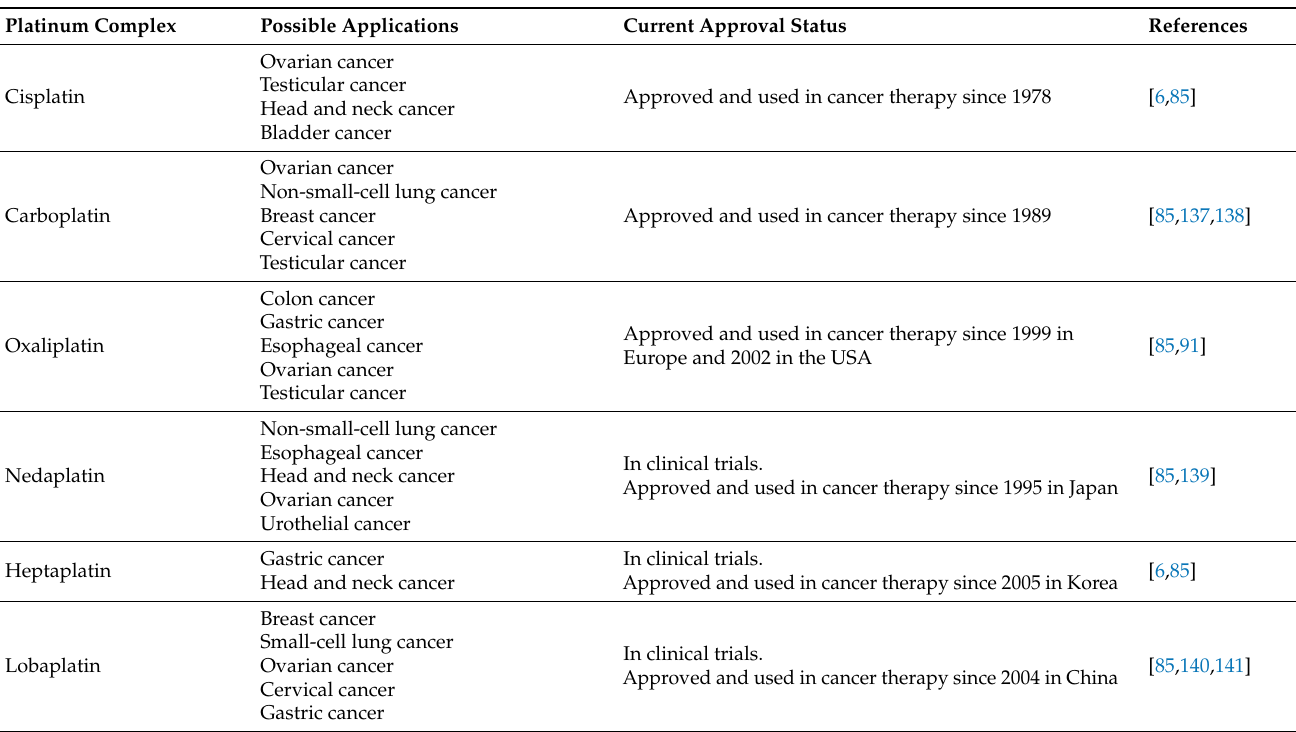
Table 2. Summary of approved and under-trial cisplatin